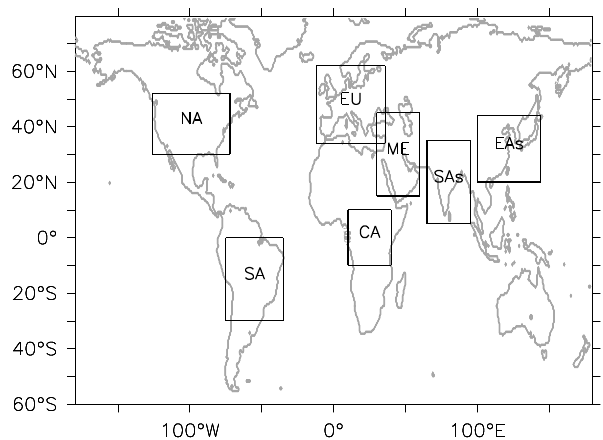
Fig. 12. Location and extension of the geographical regions used in the PW-MPI calculation. The regions are: North America (NA), Europe (EU), East Asia (EAs), South Asia (SAs), Central Africa (CA) and South America